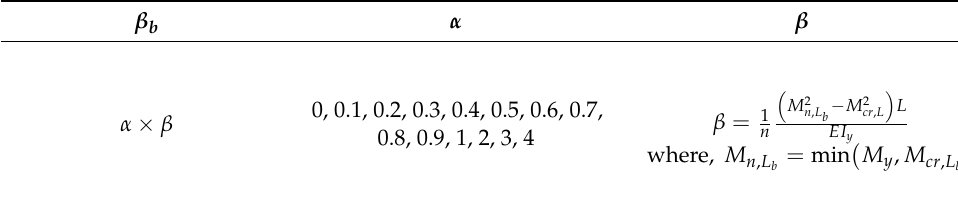
Table 3. Torsional stiffness of bracings ( β b ) used in the FEA